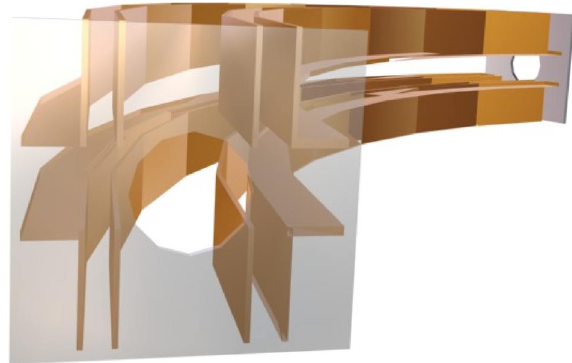
machine.FIG. 7. (Color) Electrostatic cylinder deflector with central gap for detection of charged fragments with small mass differences compared to the original beam.